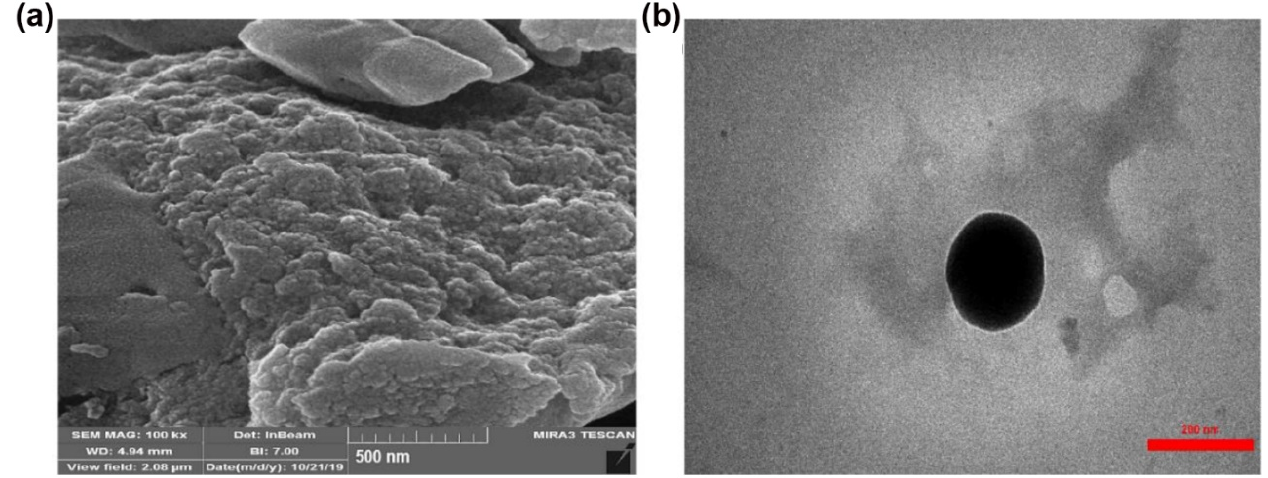
Figure 1. The scanning electron microscopy (SEM) ( a ) and transmission electron microscopy (TEM) ( b ) images of the chitosan-salicylic acid nanoparticles (CTS-SA NPs).